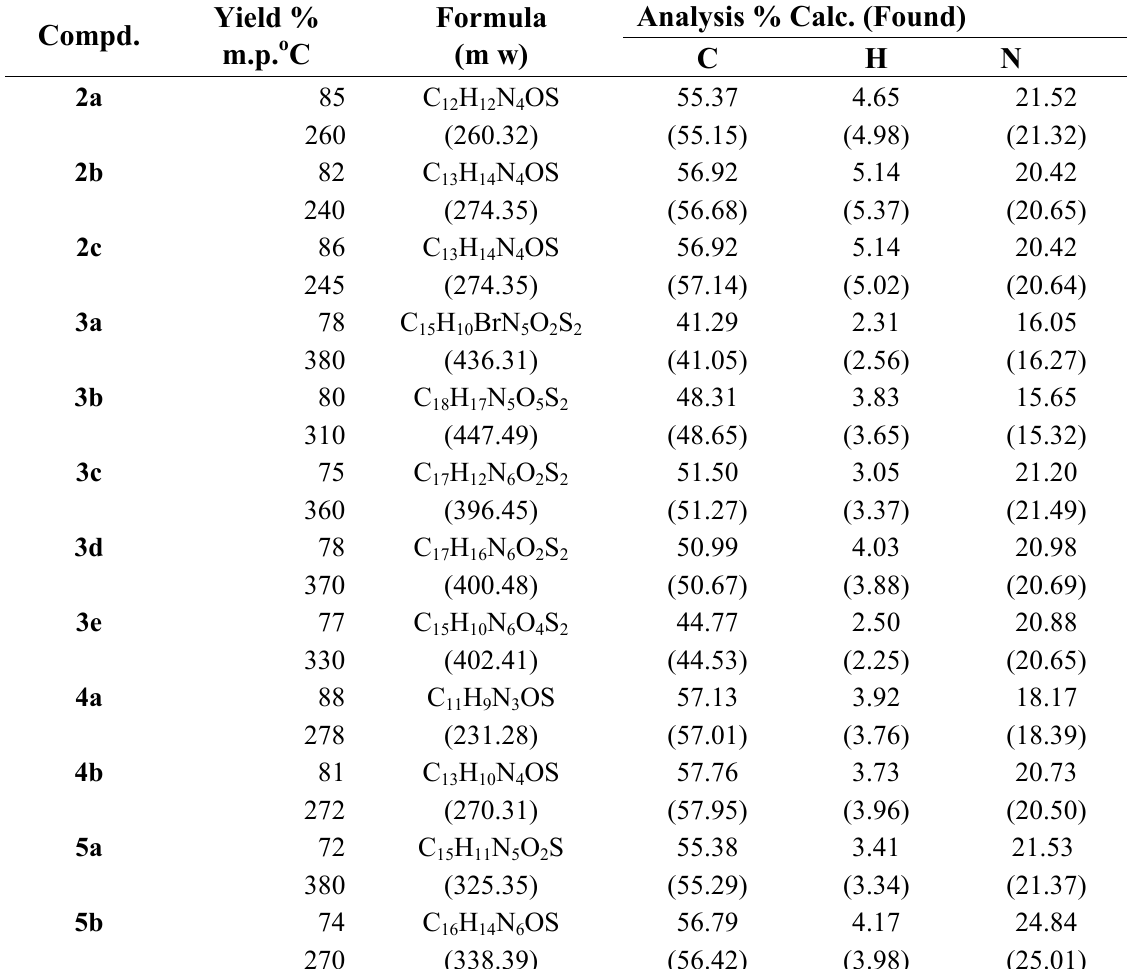
Table 3. Physical properties and elemental analyses of the new compounds.